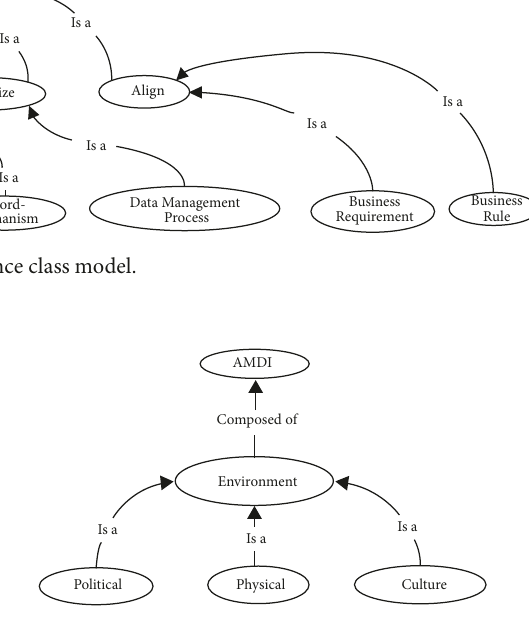
Figure 7: The environment class